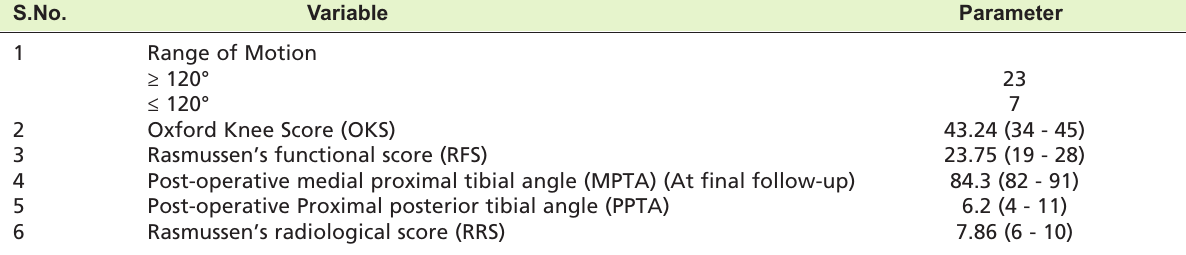
Post-operative functional scores and radiological outcome of patients Table III: S.No.